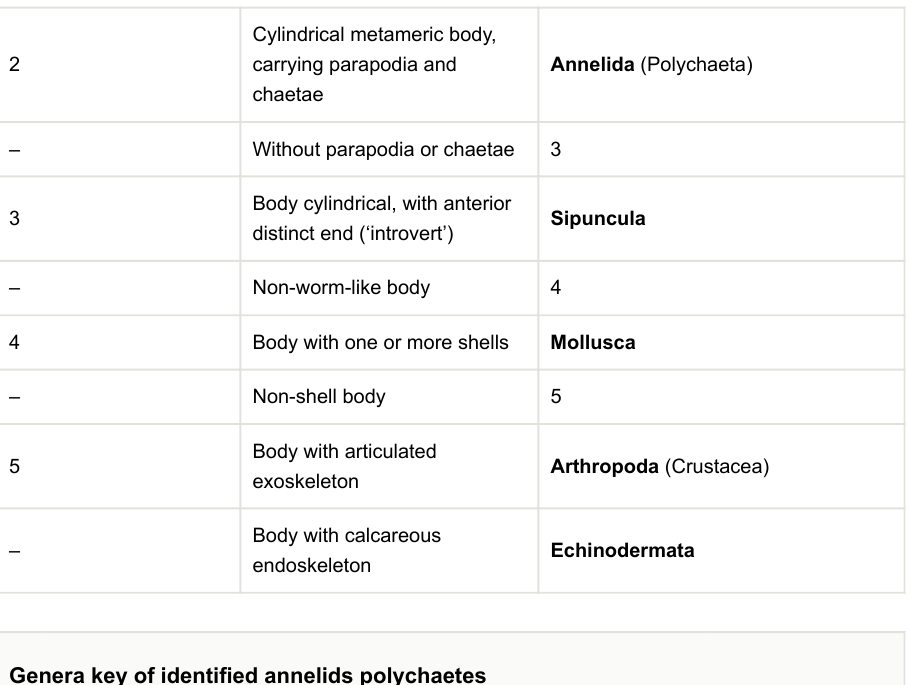
Genera key of identified annelids polychaetes Prostomium with a conspicuous protuberance (‘caruncle’), extending